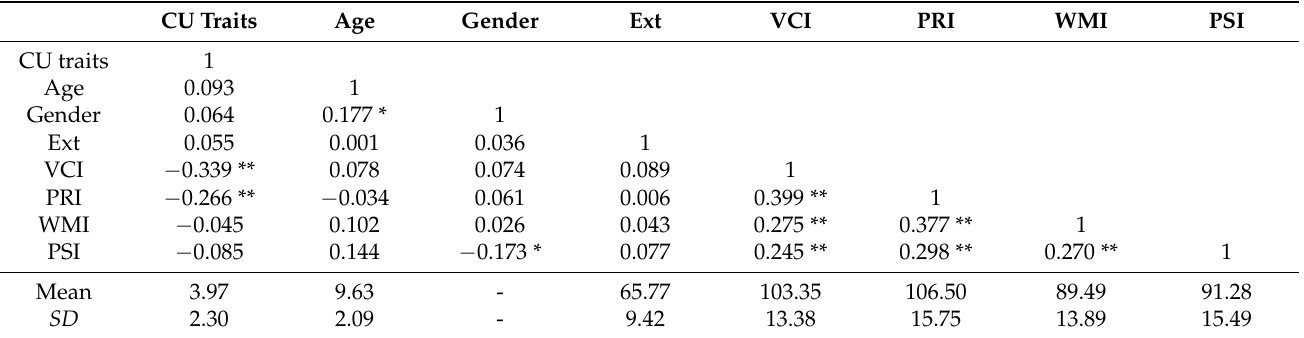
Table 1. Descriptive statistics and zero-order correlations among the study variables.